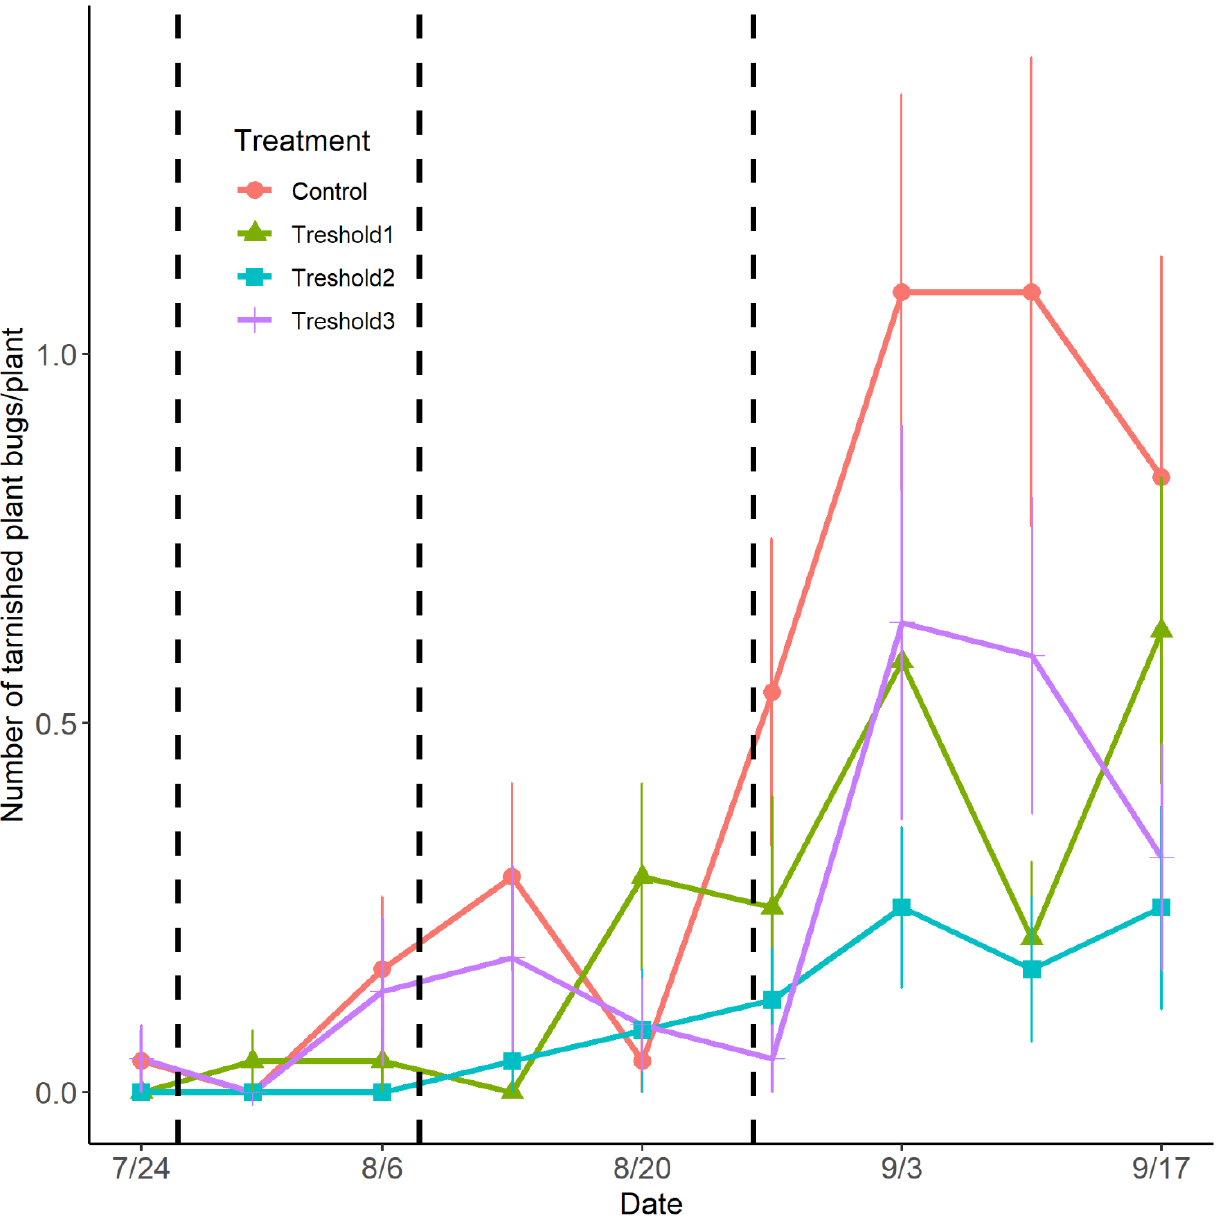
Figure 4. Seasonal variation in the population of the tarnished plant bug observed on strawberry plants depending on the release periods (release rate of 0.5 Nabis americoferus per strawberry plant). The vertical lines refer to the dates of the release (25 July, 7 August, and 25 August). The error bars correspond to standard errors.